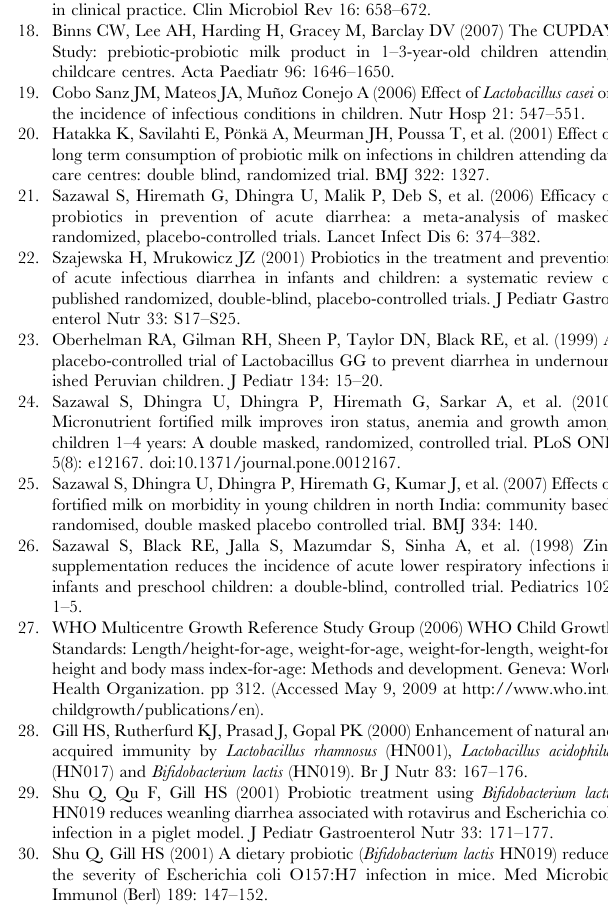
Table S6 Effect of prebiotic oligosaccharide and probiotic Bifidobacterium lactis HN019 and fortified milk on common childhood morbidities (among non malnourished